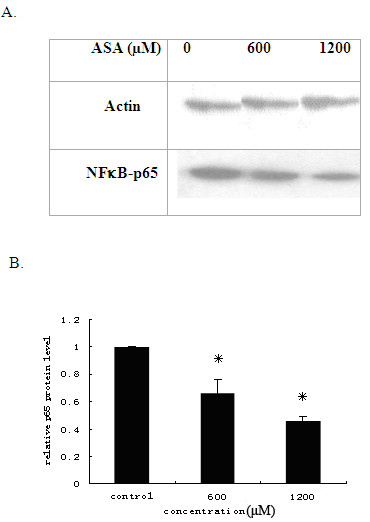
ASA inhibition of NFκ B-p65 protein nuclear translocation. THP-1 macrophages were treated with 0, 600, 1200 μM ASA, nuclear proteins were extracted and analysed by Western blot (A). Signal intensities in the blots were also measured by Quantity One software and transformed to the bar graph (B). The decrease at600, 1200 μM ASA was statistically significant ((P < 0.05). Results are expressed as mean ±S.D, of three experiments with duplicated samples. * P < 0.05,compared to control.